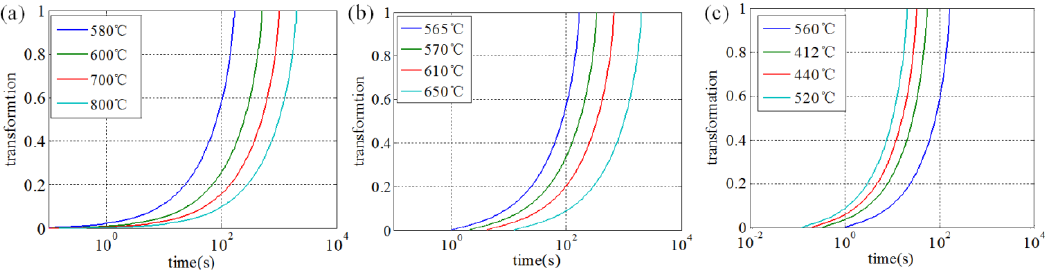
Figure 2. Dynamic curves of USIBOR ® 1500 high-strength steel; ( a ) ferrite, ( b ) pearlite, ( c ) bainite.